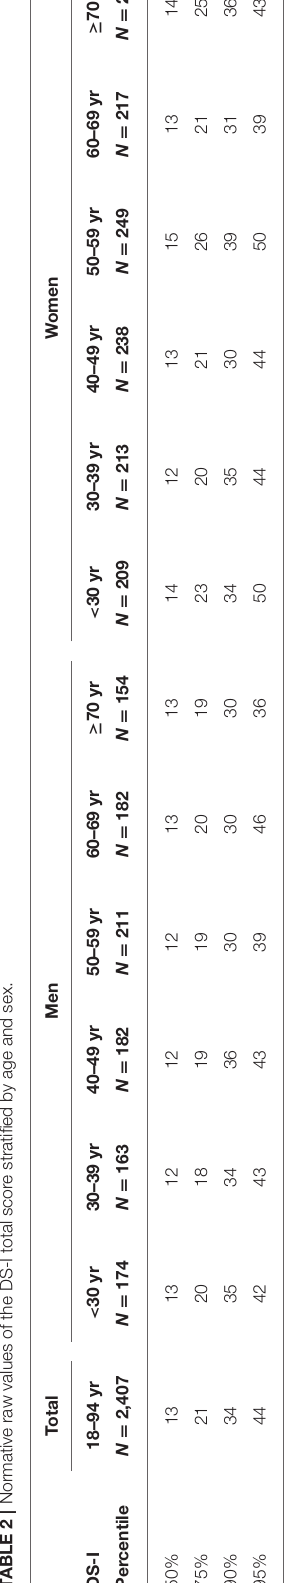
TABLE 1 | Sociodemographic sample characteristics ( N =